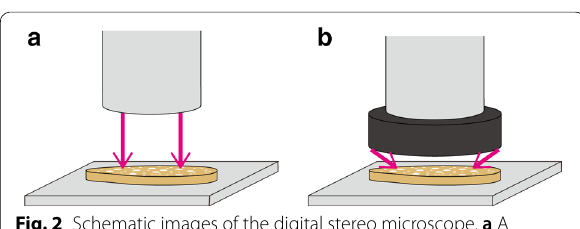
Fig. 2 Schematic images of the digital stereo microscope. a A conventional microscope illuminates normal to the surface of a sample. b An adjustable low-angled ring illumination (LaRI), which makes the boundaries of pores